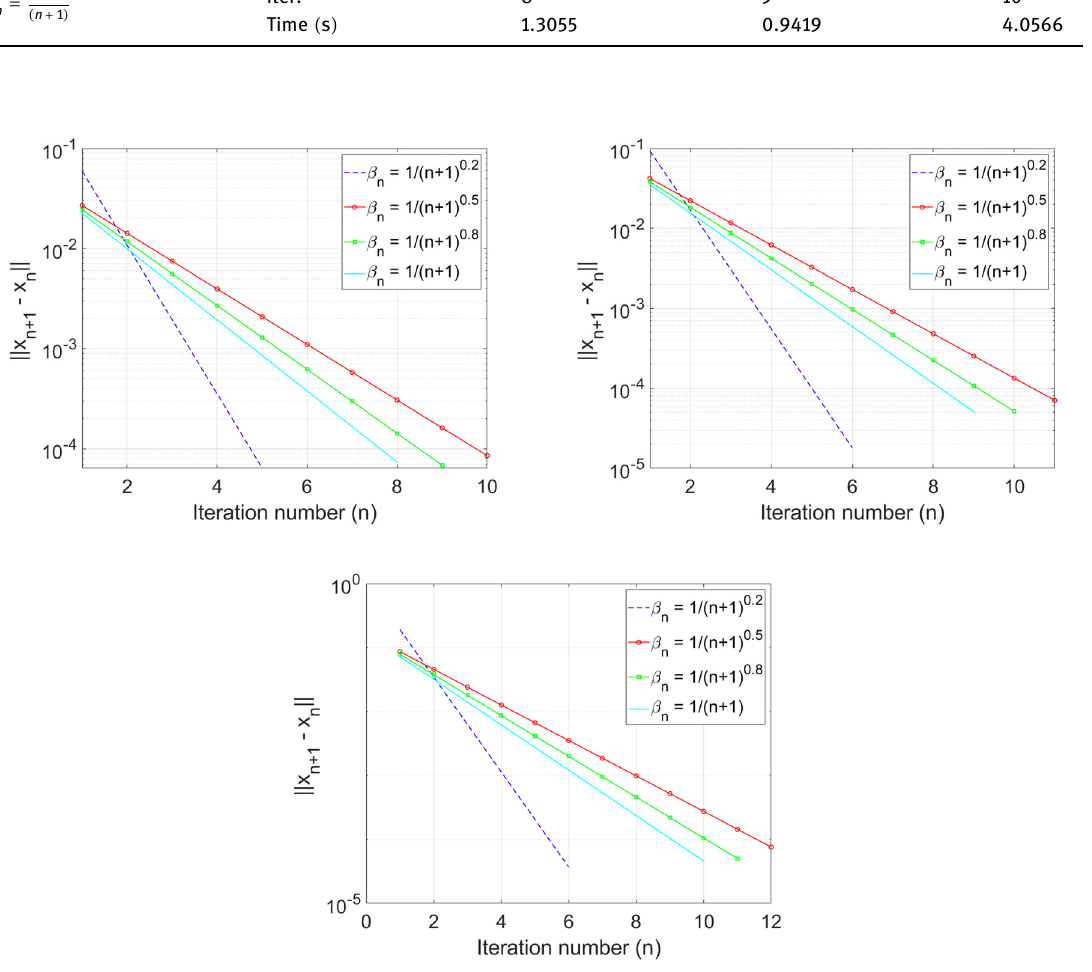
Figure 3: Example 4.2, Experiment 1, top left: Case I; top right: Case II; bottom: Case